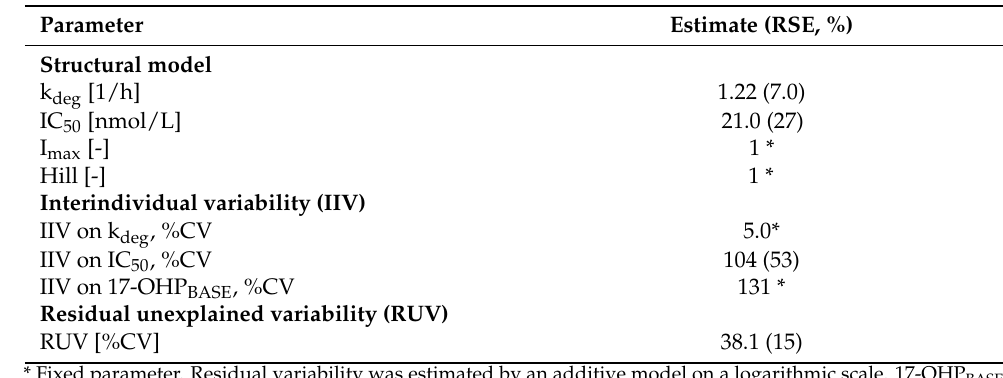
Table 1. Parameter estimates of developed pharmacokinetic/pharmacodynamic (PK/PD) model for cortisol (drug) and 17 α -hydroxyprogesterone (biomarker) concentrations in young children and